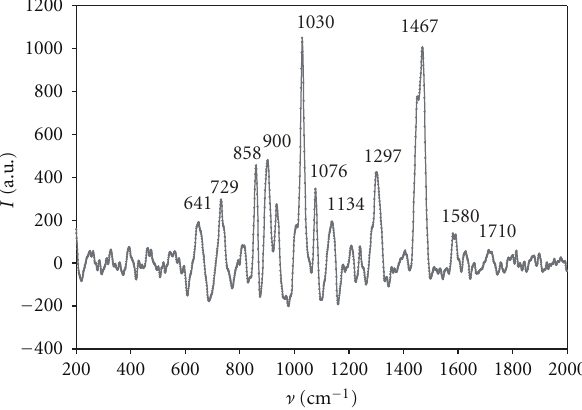
Figure 5: SERS spectrum of native glucose oxidase.